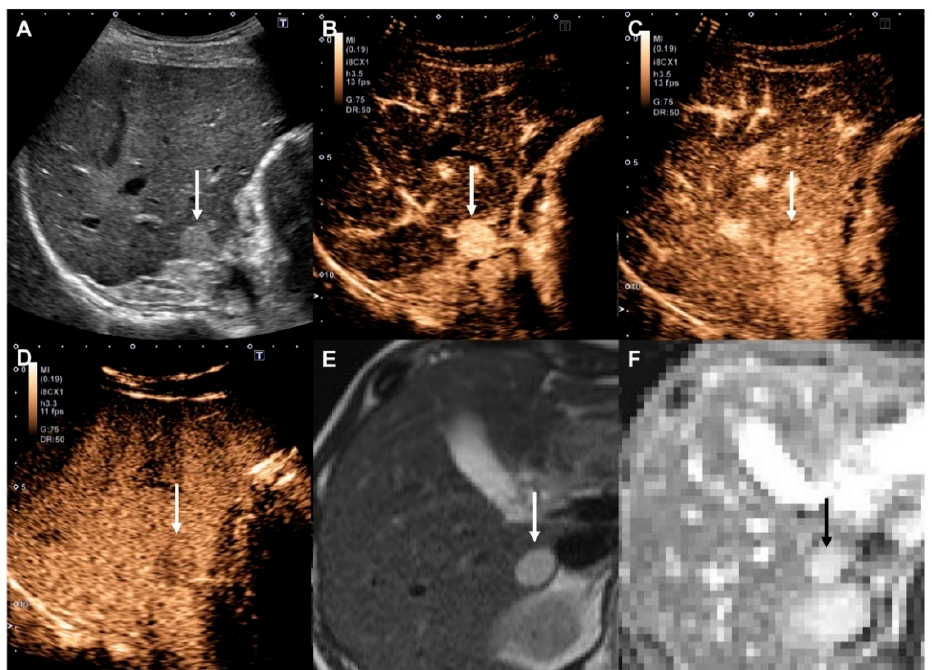
Figure 3. High-flow hemangioma in a 48-year-old woman with chronic hepatitis B. ( A ) Gray-scale ultrasound shows a clear hyperechoic mass (arrow) in the liver. ( B ) The nodule (arrow) shows hyperenhancement at 22 s in the arterial phase of Contrast-Enhanced Ultrasound (CEUS). ( C ) Enhancement persists at 51 s in the portal venous phase (arrow). ( D ) In the Kupffer phase, the nodule appears as a slightly hyperechoic mass (arrow) in the liver. ( E ) Unenhanced T2-weighted MRI shows a clear hyperintense mass (arrow) in the liver. ( F ) The apparent diffusion coefficient (ADC) map shows a hyperintense mass (black arrow), indicating lower diffusion restriction.